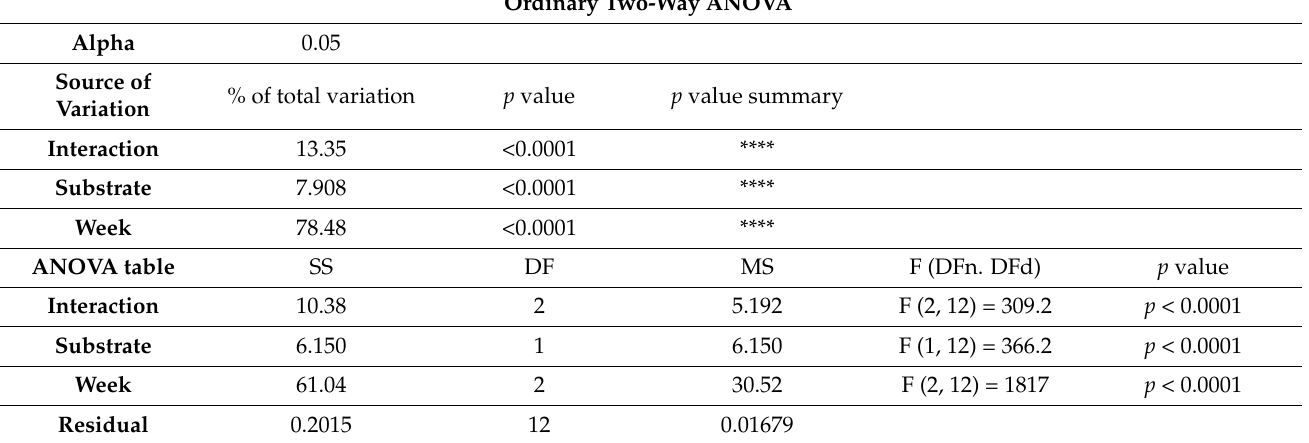
Table A10. Two-way ordinary ANOVA analysis to evaluate the effect of time and substrate on T/C in field oviposition assay and Tuckey’s multiple comparison analysis. p > 0.0123 = not significant (ns); p < 0.0001 =